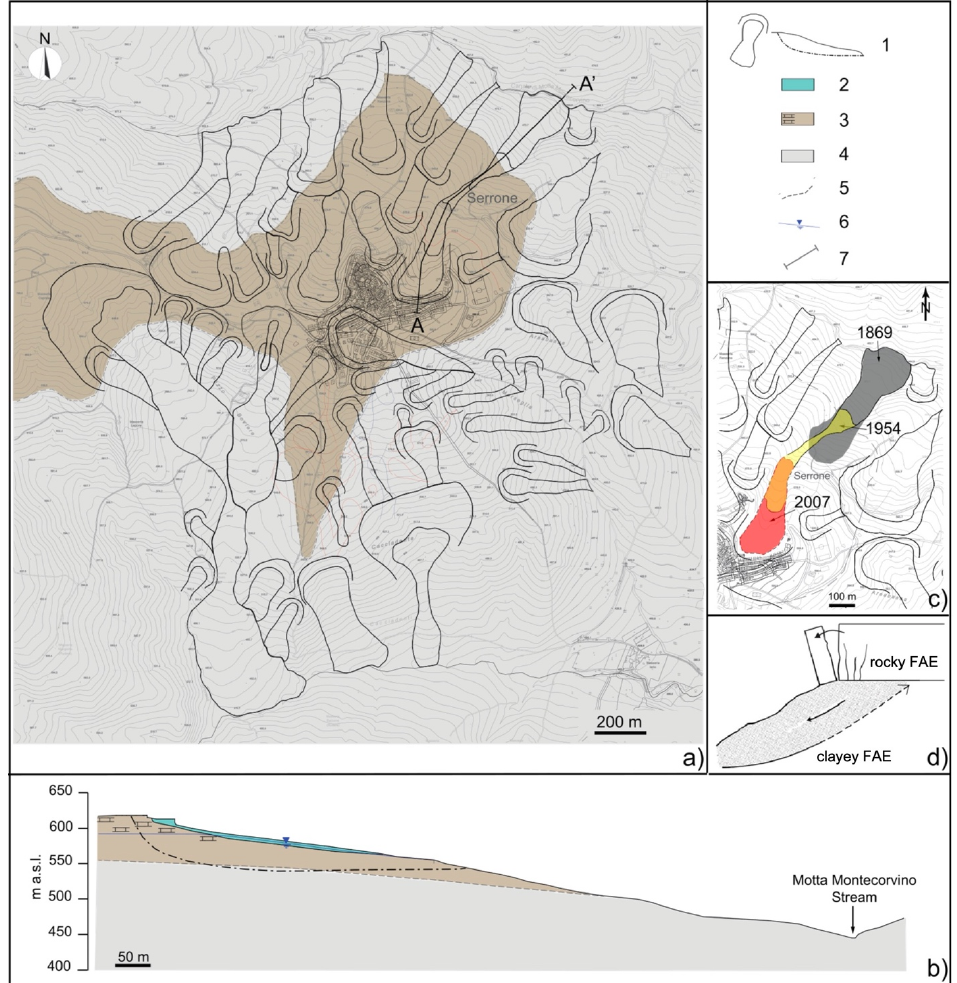
Figure 6. Motta Montecorvino: ( a ) geological map; ( b ) longitudinal cross section of Serrone landslide; ( c ) schematic geomorphological evolution of Serrone landslide from 1869 and 2007; ( d ) scheme of retrogressive evolution involving rocky Faeto Flysch. Key: (1) landslide bodies in map (left) and cross-section (right); (2) backfill; (3) Faeto Flysch (symbols indicate rocky portion); (4) Red Flysch; (5) stratigraphic contact; (6) groundwater table; (7) trace of the longitudinal cross-section.